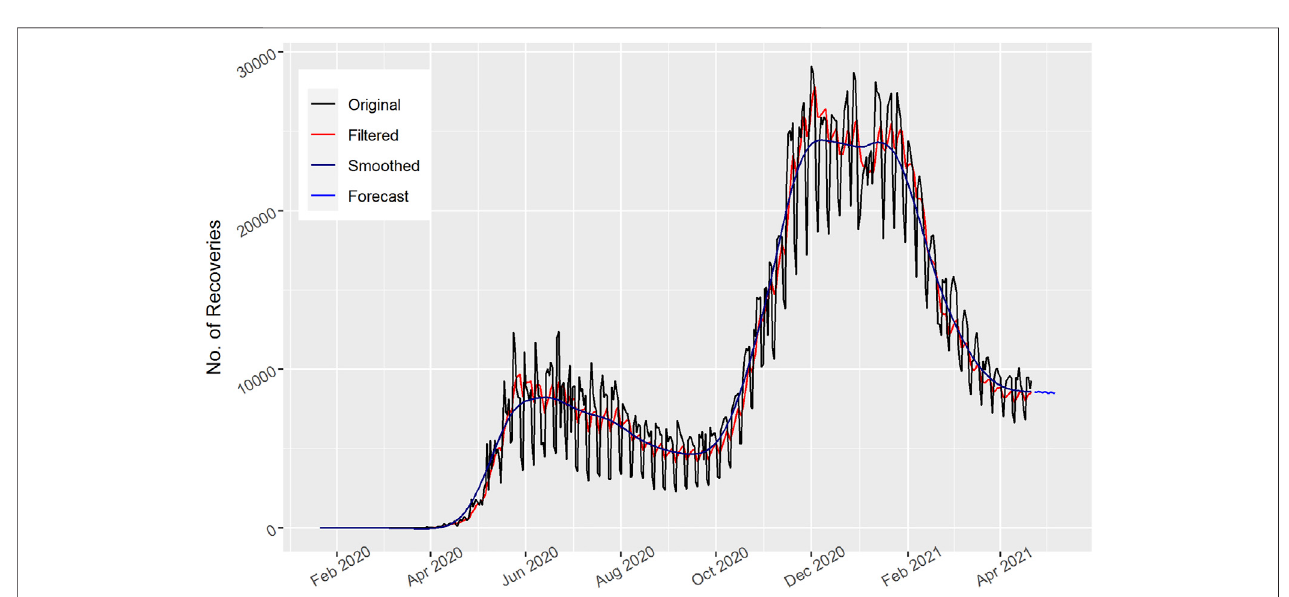
FIGURE 12 | Number of daily recovered cases in